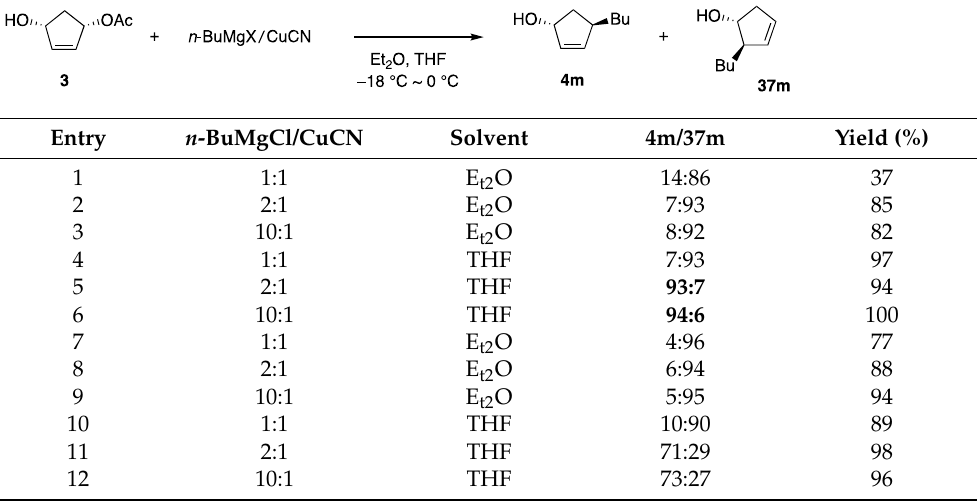
Table 6. Allylic substitution with n